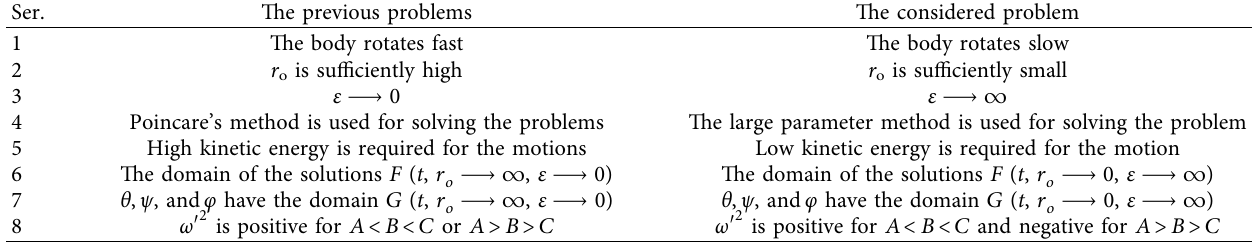
Table 1: The differences between the previous works and the considered